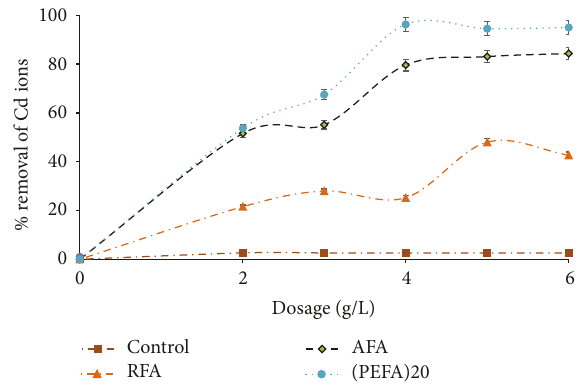
Figure 12: The influence of mixing rate on the removal efficiency of Cd (II) ions on FA based adsorbents (RFA, AFA, and PEFA) as a function of pH value of 9, 2 mg/L metal ion concentration, contact time of 15 min, 4 g/L adsorbent dosage, 50 mL volume of aqueous solution, and 298 K temperature.